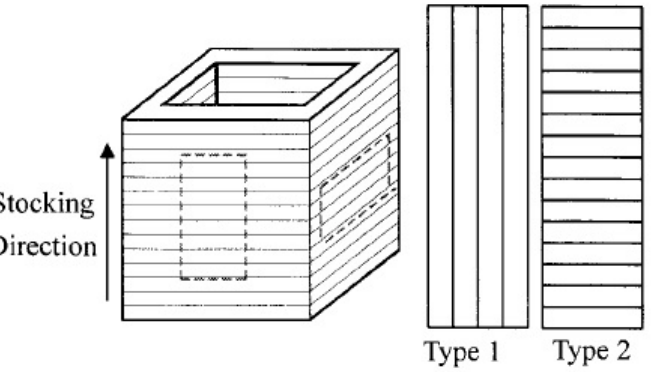
© 2001 with permission from